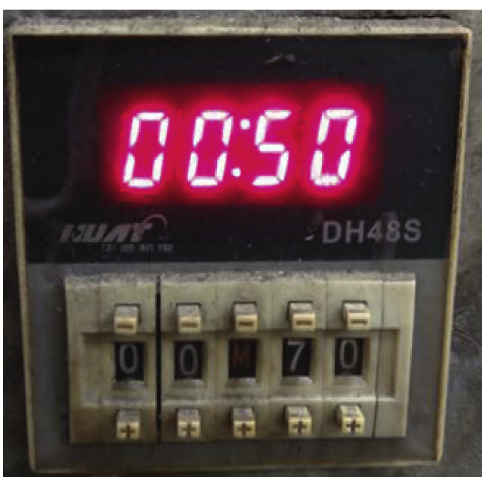
Figure 7: Setting heating